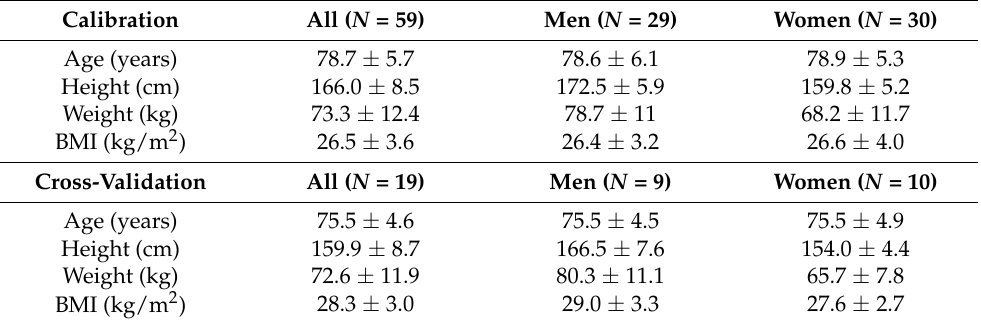
Table 2. Descriptive characteristics of participants in the calibration (AREA) and cross-validation (MOBEMENT)